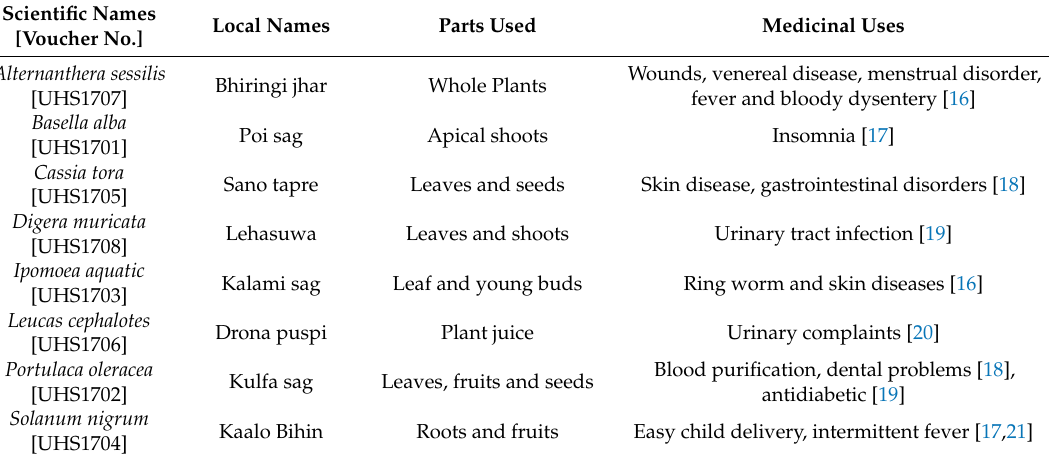
Table 1. Scientific names, voucher numbers, local names, parts used, and medicinal uses of selected wild leafy